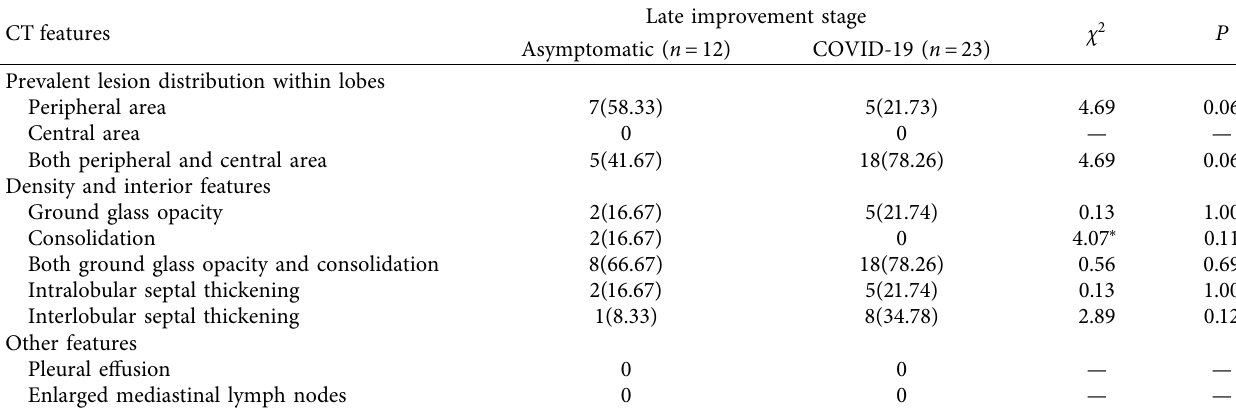
Table 6: Imaging features of asymptomatic carriers and COVID-19 patients at the late improvement stage [ n